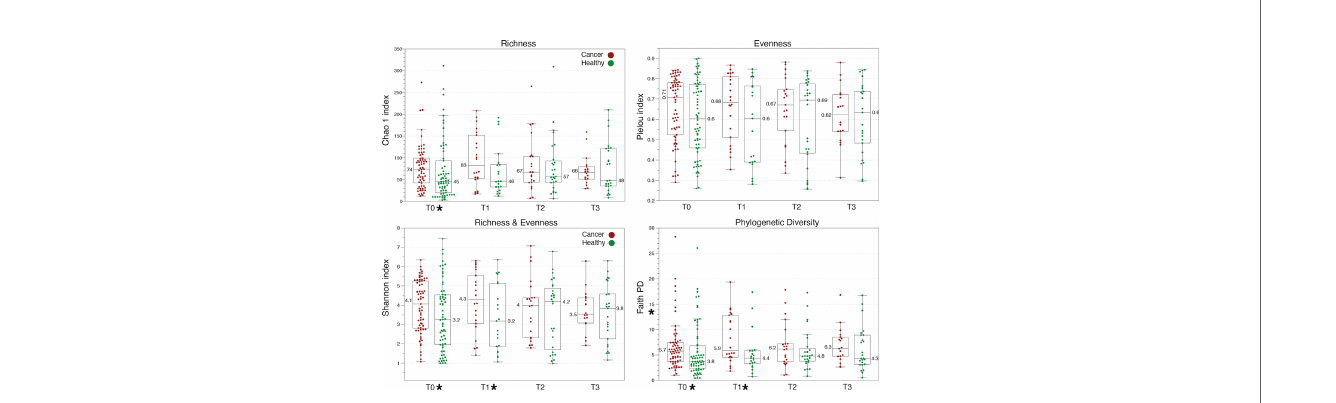
FIGURE 2 | Comparison of a -diversity metrics among healthy and gynecologic cancer vaginal microbiome communities. Cancer patients exhibit higher a -diversity than healthy controls at baseline, which further increases at T1, upon completion of therapy. Star symbols indicate a p-value <0.01 in Kruskal-Wallis test between cancer and